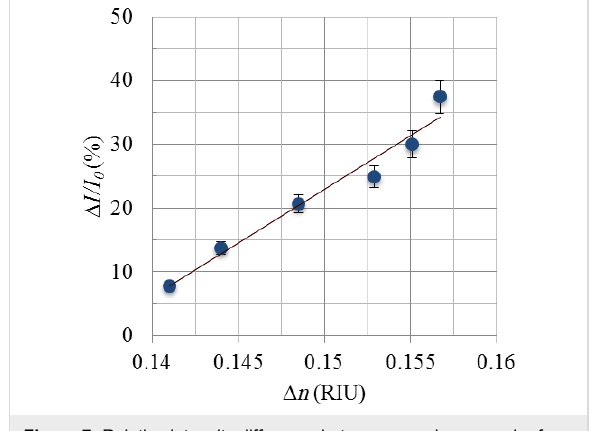
Figure 7: Relative intensity difference between sample arm and refer- ence arm vs refractive index difference (between PMMA and sucrose